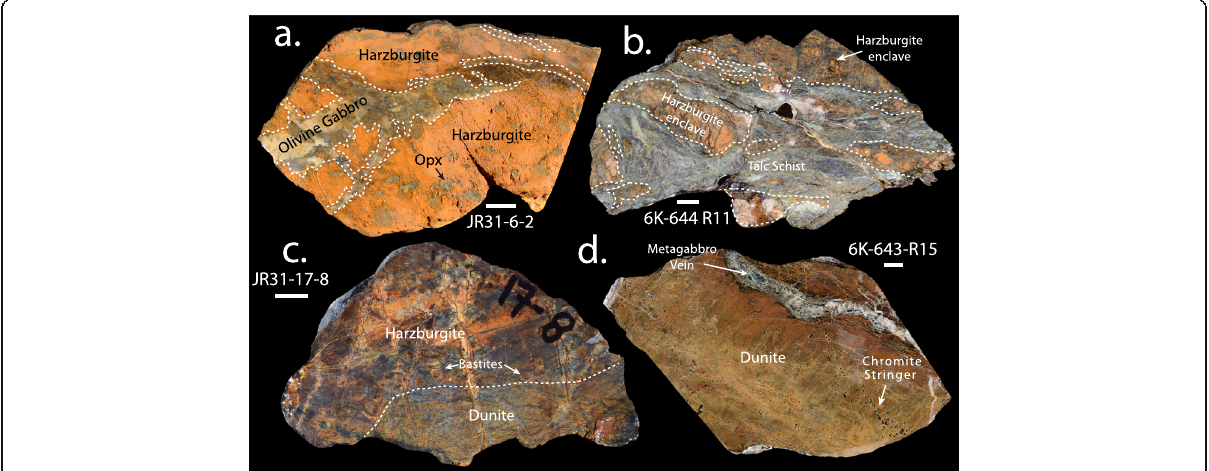
Fig. 33 Pyroxene-poor harzburgite and dunite samples from Atlantis Bank indicative of late-stage melt transport in the shallow mantle. a Deeply weathered, pyroxene-poor harzburgite cut by a stockwork of olivine gabbro veins from Dredge JR31-6 on the northern secondary detachment fault surface (Fig. 3). All olivine is altered to orange clay, whereas the plagioclase in the veins appears to be altered to prehnite and hydrogrossular garnet. b Talc schist with enclaves of deeply weathered, pyroxene-poor harzburgite from the normal fault face on the eastern flank of Atlantis Bank at 57° 21 ′ E (Fig. 29b). The paragenesis is that of high-temperature fault gouge initially intruded up a shear zone due to formation of talc with infiltration of water into the mantle above serpentine stability field with subsequent serpentinization. c Cobble of massive statically serpentinized harzburgite crosscut by dunite dredged from the intersection of the primary detachment fault with the 57° 18 ′ E Normal Fault face on the eastern edge of the wave-cut platform (Fig. 3). d Dunite block with local spinel stringers cut by a metagabbro vein from 46 m below the gabbro-mantle contact high on the transform wall at 54° (Fig.